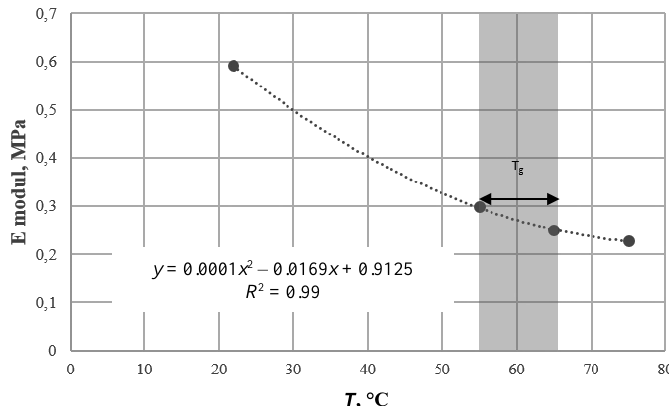
Fig. 5. Relationship of E modulus with test